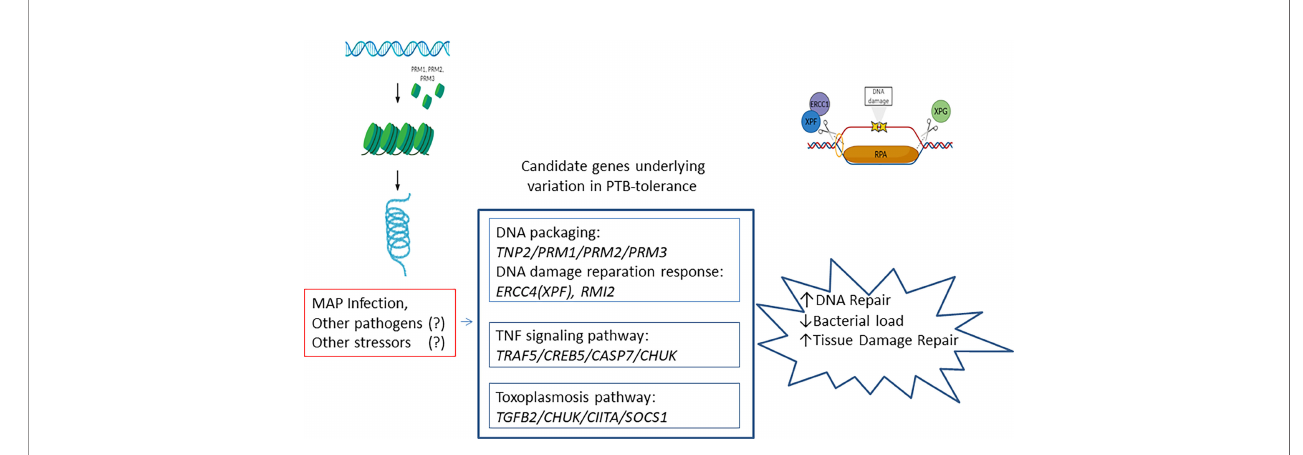
FIGURE 3 | Schematic diagram illustrating the identi fi ed PTB-tolerance mechanisms. Candidate genes involved in DNA packaging, TNF signaling pathway, and toxoplasmosis were associated with the PTB tolerant individuals. These mechanisms play conserved and important roles in